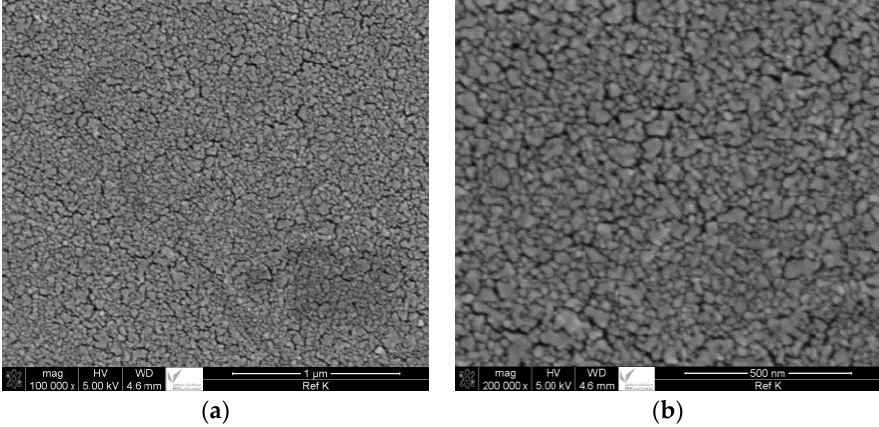
Figure 1. SEM images of PS membrane. ( a ) 100 k and ( b ) 200 k magnification.